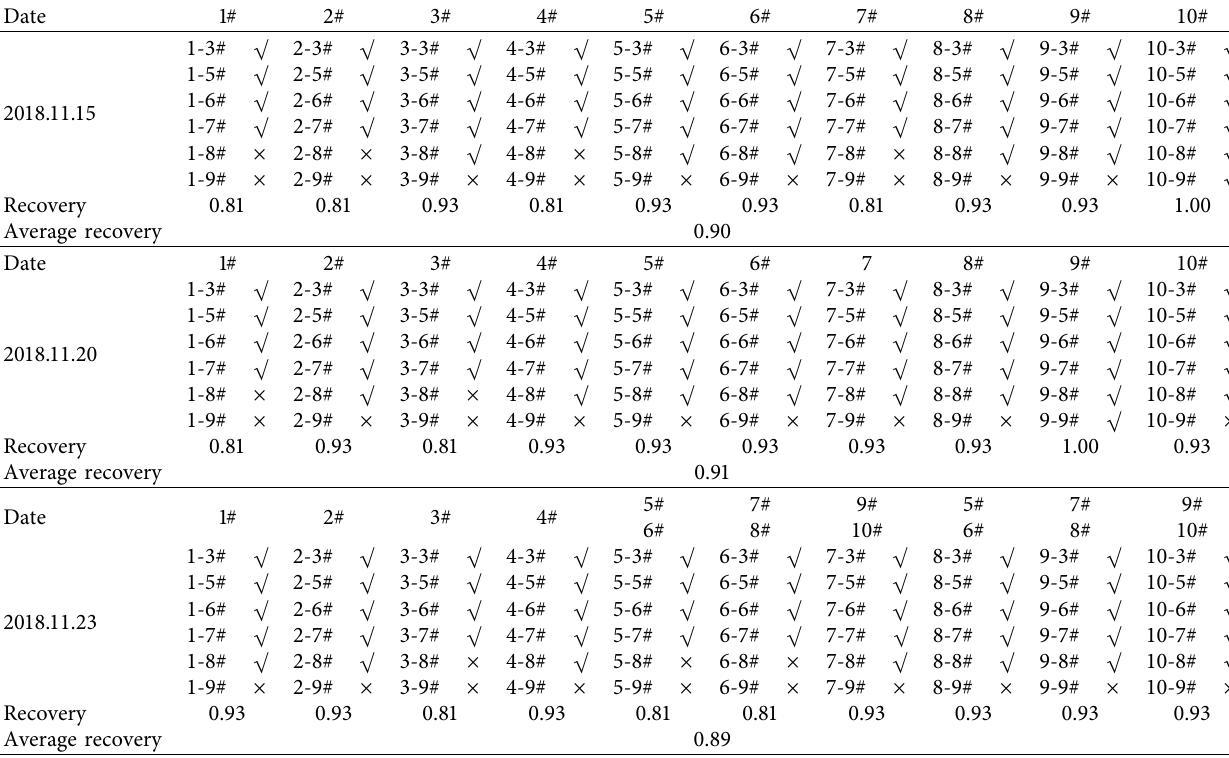
Table 5: Monitoring data of top coal recovery under the condition of two cutting and one caving with single-sequence coal caving (“ √ ” means the monitoring point has been recovered, “ × ” means the monitoring point has not been